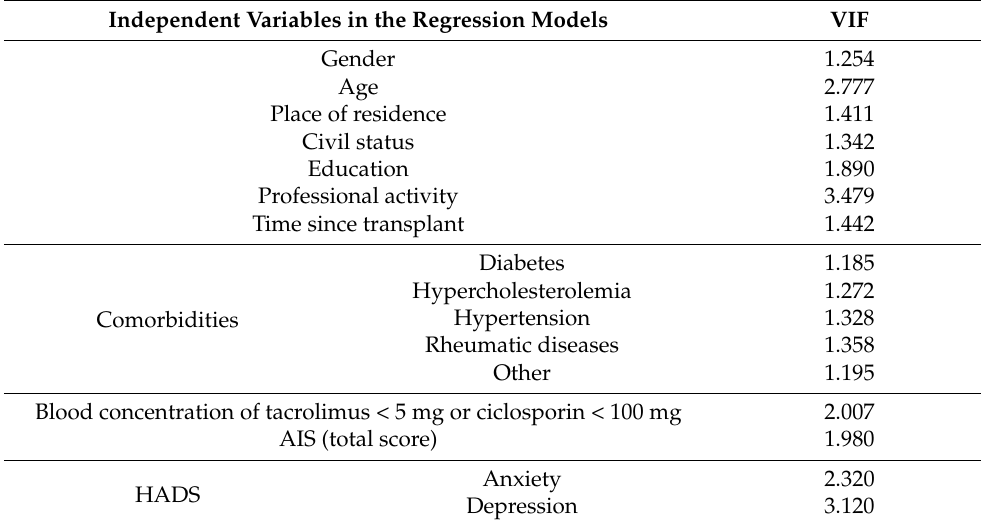
Table 1. Variance inflation factors (VIFs) measure the amount of multicollinearity in the regression